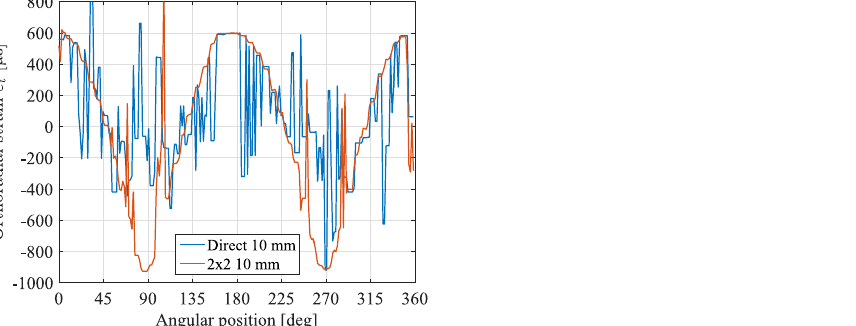
Figure 7. Comparison between two approaches of cross-correlation: “direct” is the direct cross- correlation between raw measurements and the reference, “2 × 2” is the cross-correlation between subsequent